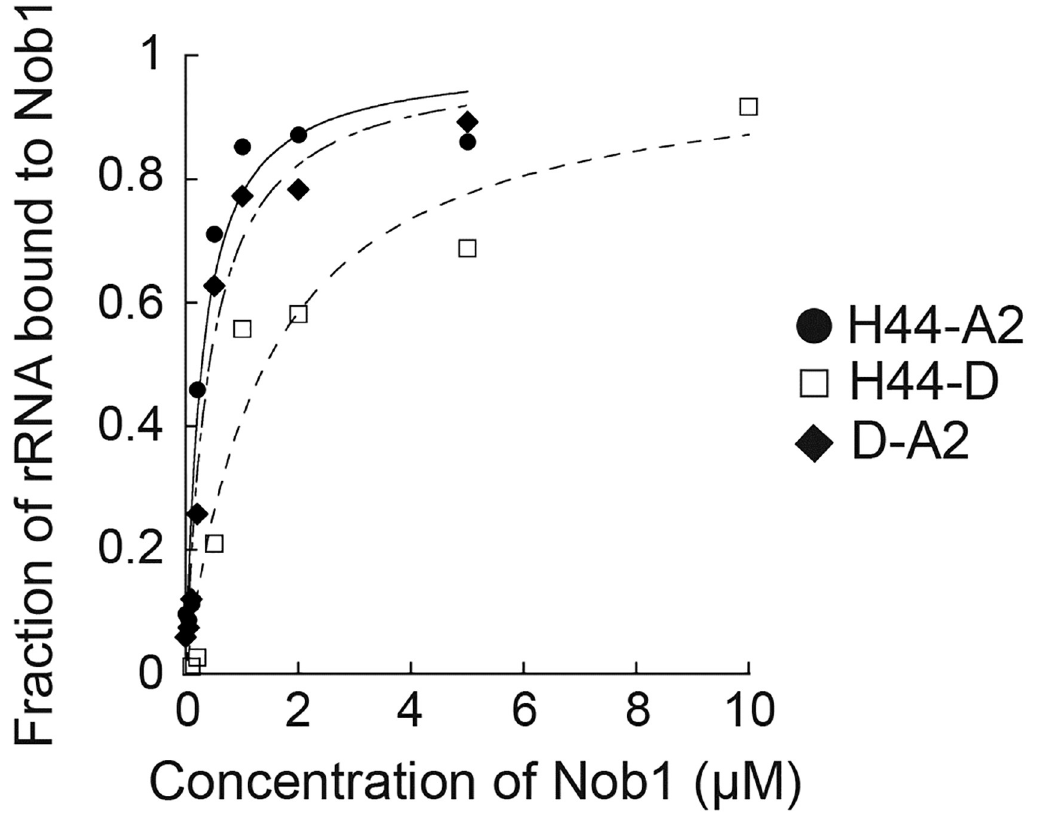
Fig 2. Nob1 dissociates with the 3 0 -cleavage product following rRNA cleavage. Representative RNA binding assay with in vitro transcribed H44-A2 (20S pre-rRNA mimic, black circles), H44-D (18S rRNA mimic, white squares), or D-A2 (3 0 -ITS1, black diamonds) RNAs and with recombinant Nob1. Four or five independent experiments yielded values of K d = 0.93 +/ − 0.09 μ M for Nob1 binding H44-A2, K d = 0.96 +/ − 0.05 μ M for Nob1 binding D-A2, and K d = 1.89 +/ − 1.04 μ M for Nob1 binding H44-D. Numerical data are listed in S1 Data. ITS1, Internal transcribed spacer